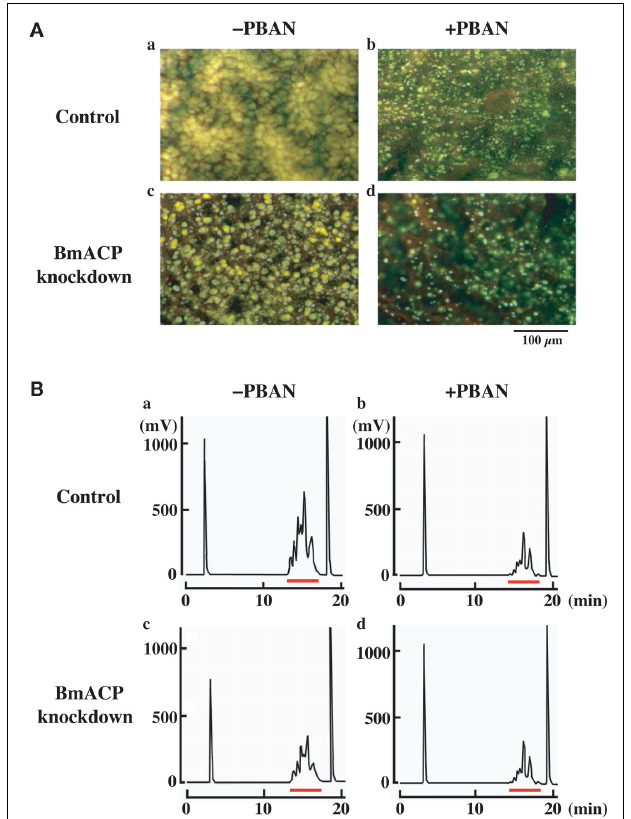
FIGURE 6 | Effect of RNAi-mediated knockdown of BmACP on in vivo LD dynamics. (A) Effect of RNAi treatment on cytoplasmic LD dynamics. PGs were dissected from 1-day-old decapitated female moths previously injected with either DEPC-treated H 2 O (control) or 10 μ g BmACP dsRNA (BmACP knockdown) shortly after pupation. After eclosion, females were decapitated within 3h of emergence, maintained at 25˚C for 24h, and then injected with PBS alone ( − PBAN) or 5pmol B. mori PBAN ( + PBAN). PBAN was injected three times at 3-h intervals. Cytoplasmic LDs were stained with the fluorescent lipid marker, Nile Red. Magnifications, 400 × . (B) Effect of RNAi treatment on totalTAG contents of the cytoplasmic LDs. One-day-old pupae were injected with DEPC-treated H 2 O (control) or 10 μ g BmACP dsRNA (BmACP knockdown). After eclosion, females were decapitated within 3h of emergence, maintained at 25˚C for 24h, and then injected with PBS alone ( − PBAN) or 5pmol of B. mori PBAN ( + PBAN). PBAN was injected three times at 3-h intervals. Five PGs were extracted with acetone 90min after PBAN injection, and the extract was subjected to HPLC on a PEGASIL-Silica column (Matsumoto et al., 2002).The relevant TAG fractions are underlined in red;TAGs were detected using an evaporative light scattering detector